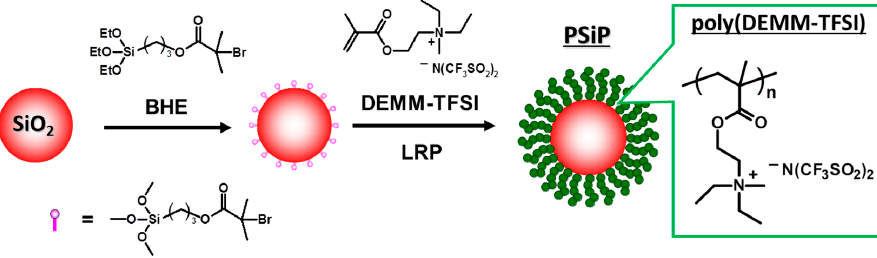
Figure 5. Schematic representation of the synthesis of SiP grafted with poly(DEMM-TFSI) brushes by surface-initiated ATRP.